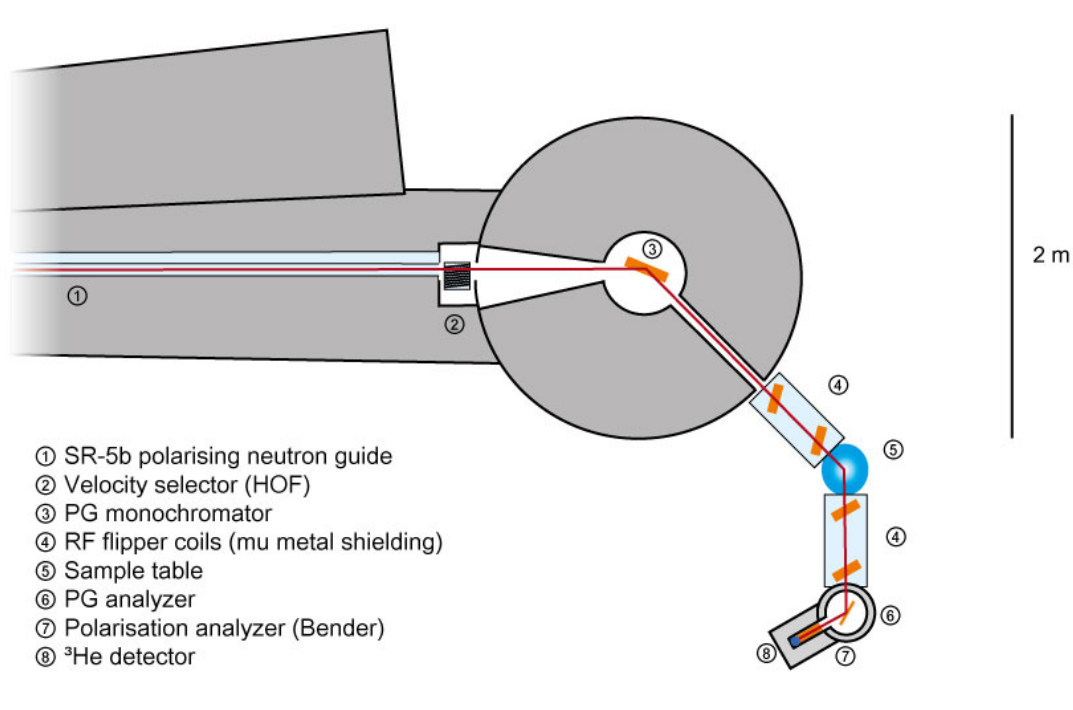
Figure 2: Schematic drawing of